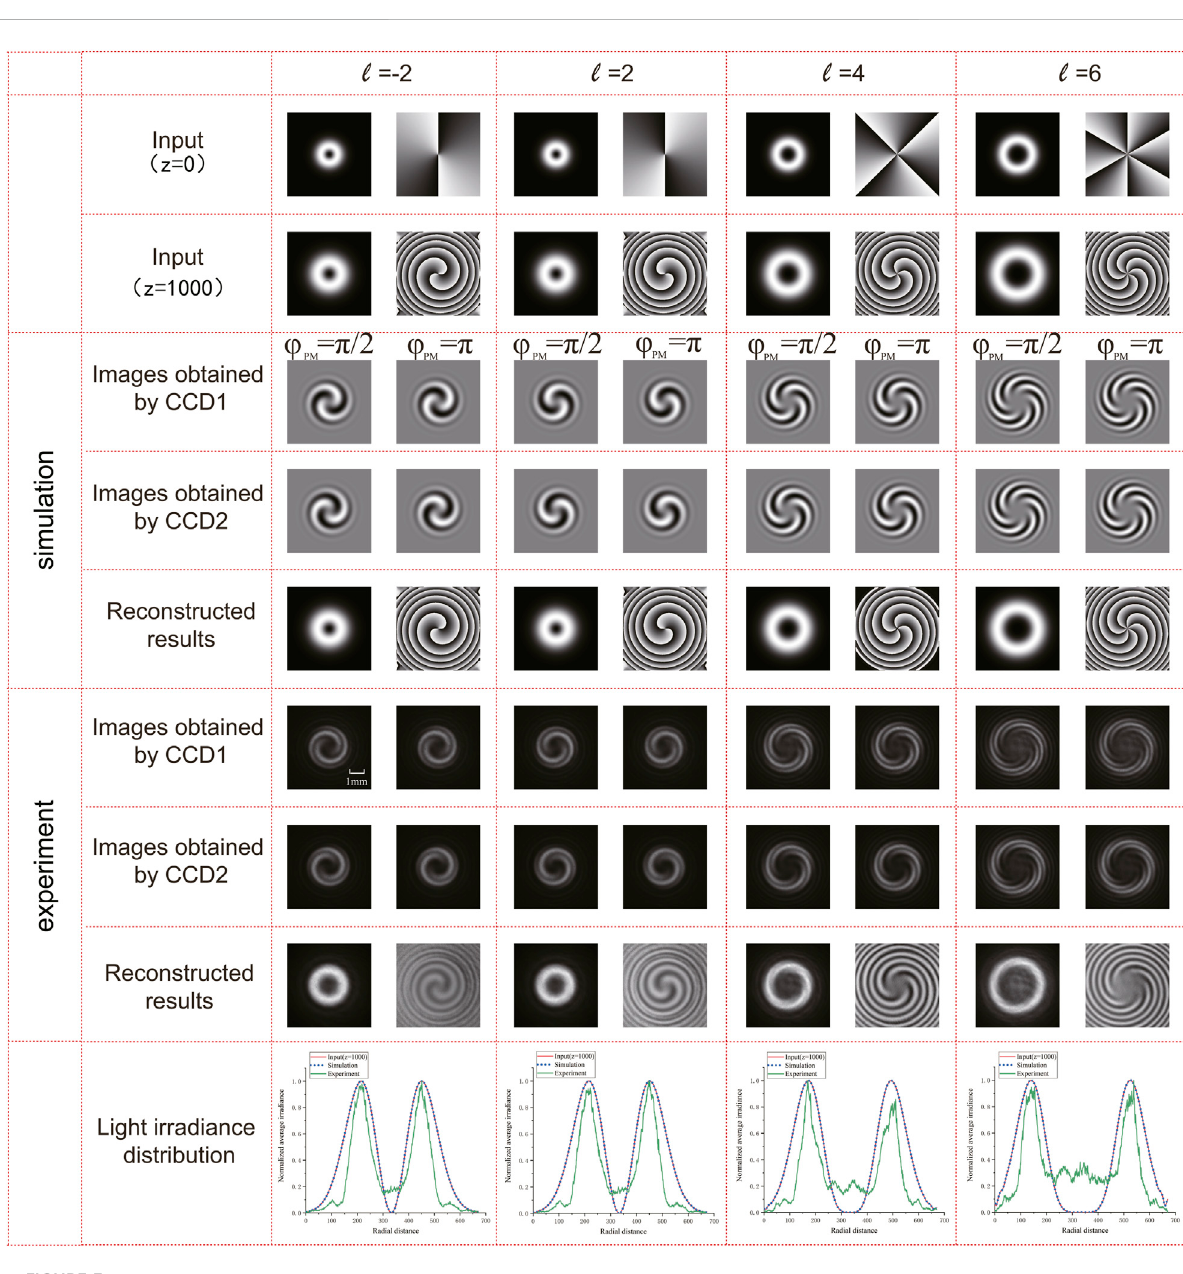
FIGURE 3 Simulation and experimental results of the proposed scheme to capture the amplitude and phase pro fi le of single OAM beam E in .